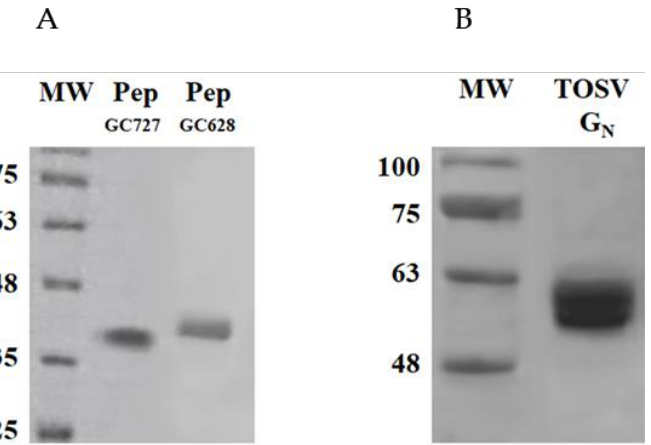
Figure 3. SDS_PAGE of TOSV recombinant proteins. ( A ) 5 µg of purified pep GC683 and GC727 and ( B ) TOSV Gn protein were analyzed on a 12% polyacrylamide gel under reducing conditions and stained with Coomassie Blue. MW: SharpmassVI, Euroclone.